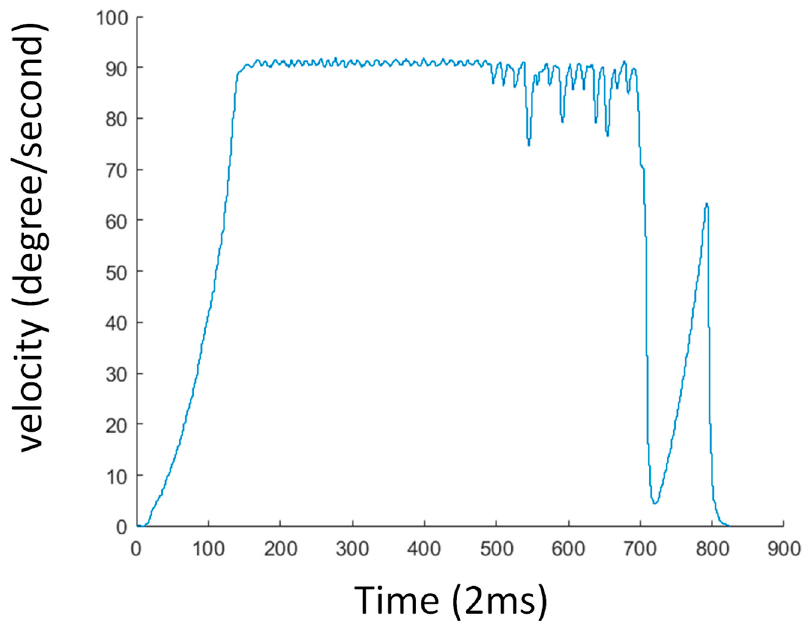
Figure 7. Trajectory of feedback velocity.